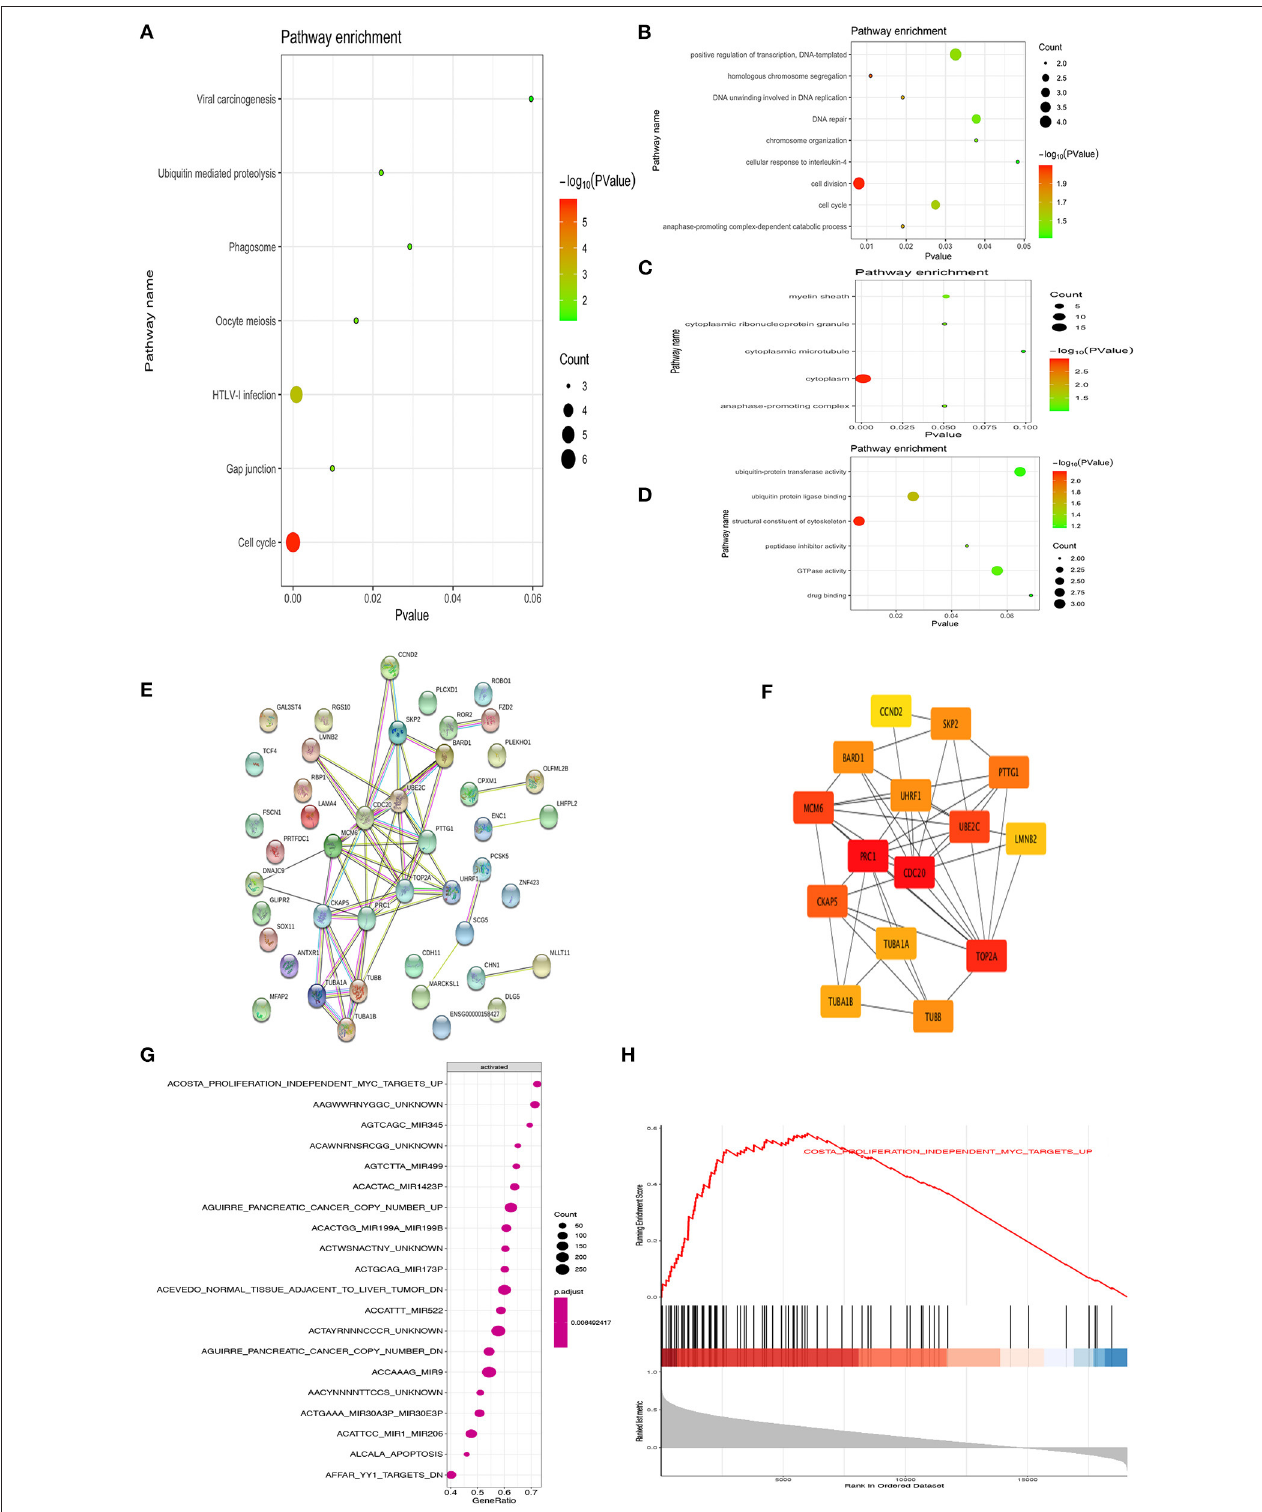
FIGURE 2 | Bioinformatics analysis of different genes. Gene ontology analyses of the common up-regulation DEGs according to biological process, cellular component and molecular function (A–D) . PPI network of the common DEGs identified from GSE66405, GSE73029, and TCGA was constructed (E) . The sub-networks were identified by Cytoscape MCODE plugin (F) . Gene set enrichment analysis of CDC20 related genes from TCGA datasets (G,H) .